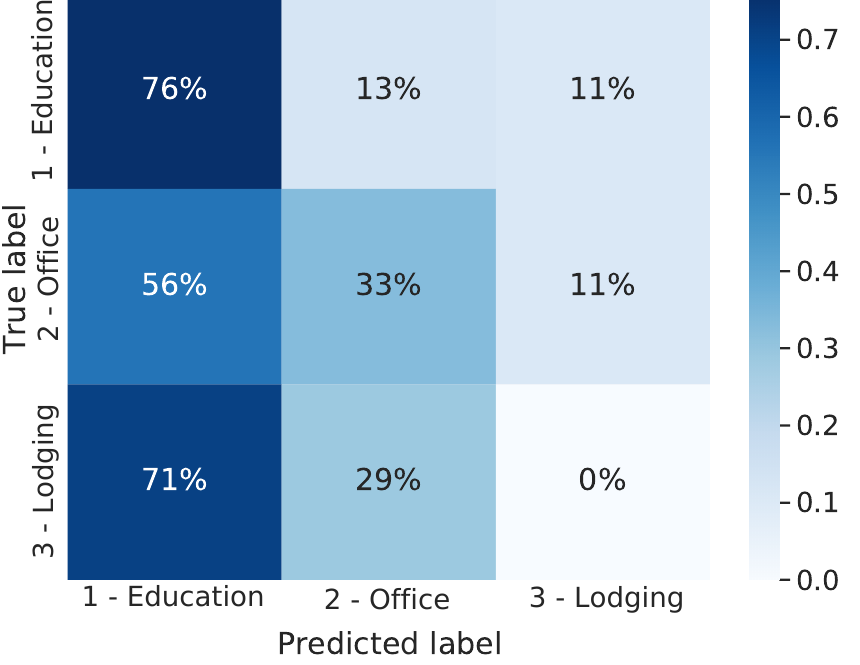
Figure 7. ANN-E normalized confusion